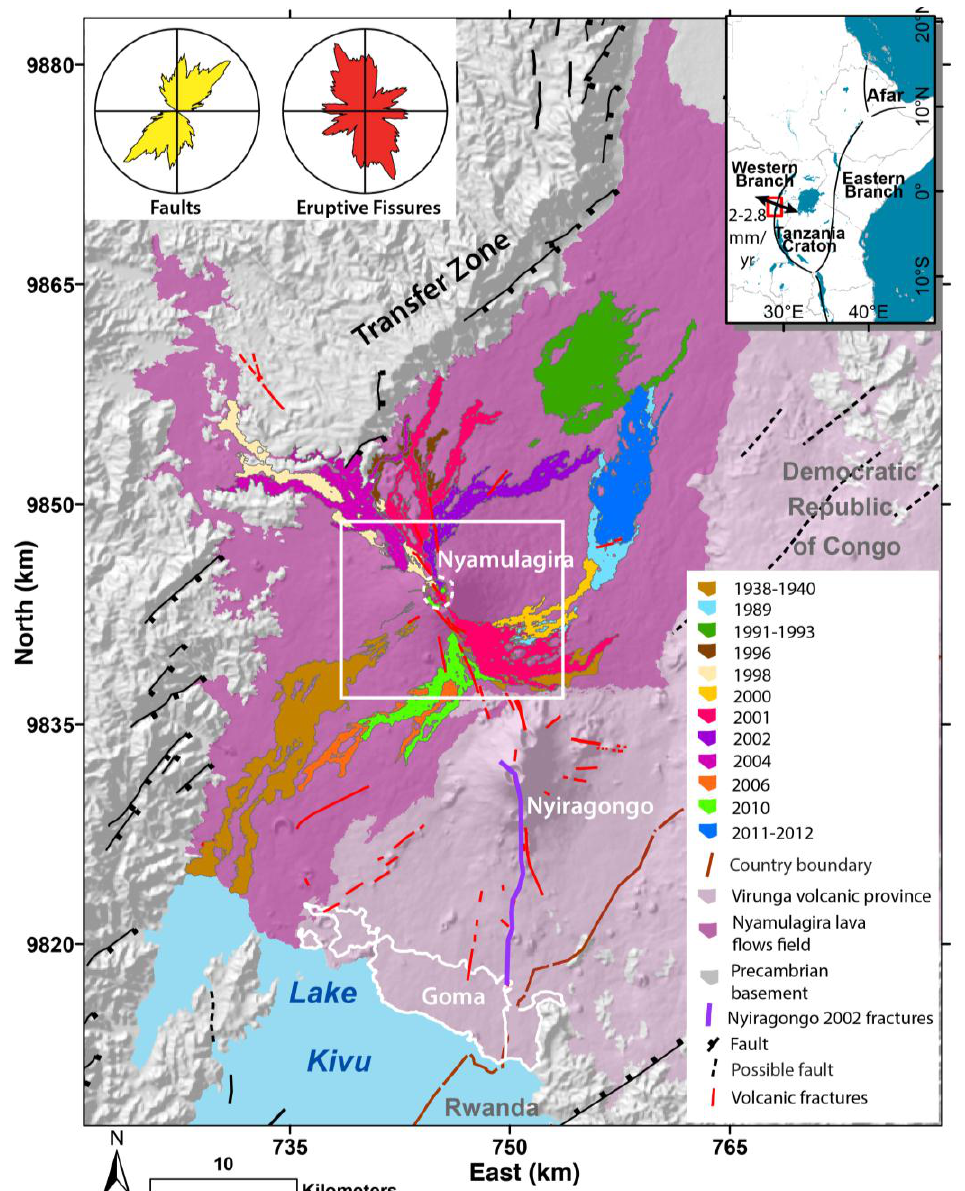
Figure 1. Geological setting of the Virunga Volcanic Province (VVP), western branch of the East African Rift System (EARS), north of Lake Kivu. The rift extension direction in this area is ~N110E, with an estimated extension rate of 2-2.8 mm/year [11,12]. The Goma–Gisenyi urban area is outlined in white on the northern shores of Lake Kivu. Eruptive fissures and lava flows (see the legend) were mapped from radar and optical images [7]. Nyamulagira’s caldera rim is outlined with a white dashed line. Faults are from [13], and rose diagrams of VVP’s faults (yellow) and eruptive fissures (red) are from [9] . The white rectangle gives the extent of Figure